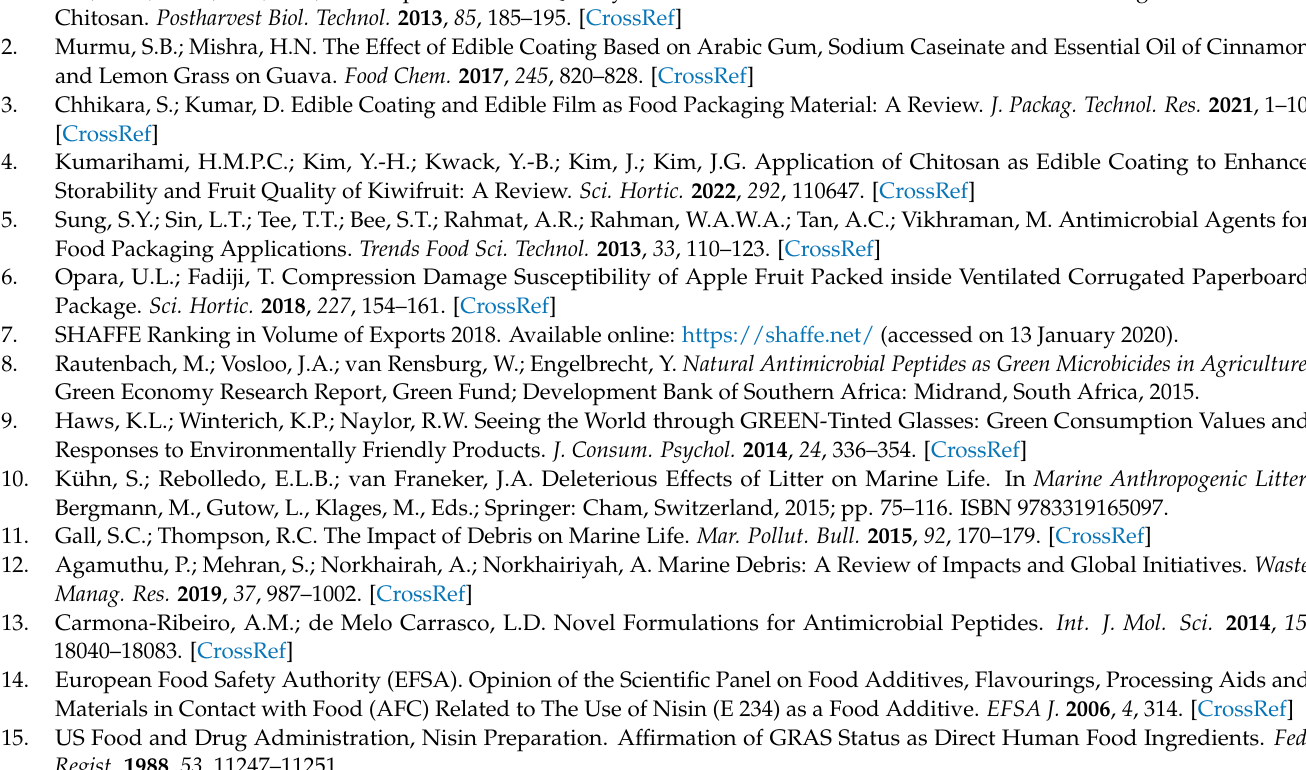
Table S2: Summary of statistical analysis between Trc mix and lab acquired materials for the activity against L. monocytogenes ; Table S3: Summary of statistical analysis between Trc mix and commercial materials for the activity against L. monocytogenes ; Table S4: Summary of the statistical analysis between the activities observed for antibiotic treated cellulose against L. monocytogenes ; Table S5: Summary of the statistical analysis between the activities observed for antibiotic treated cellulose against E. coli